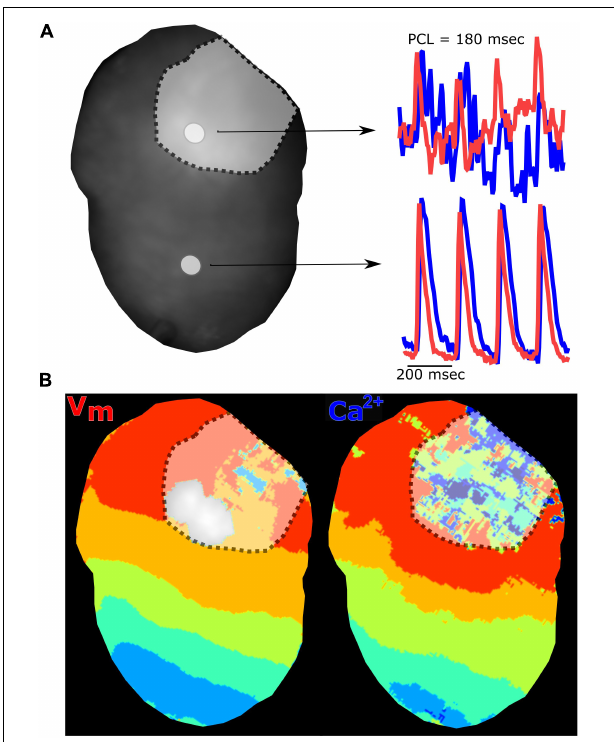
FIGURE 9 | Myocardial injury via radiofrequency ablation diminishes electrical and calcium signals. (A) Langendorff-perfused rat heart after radiofrequency ablation showing two regions of interest and corresponding traces. The voltage signal (red) and calcium signal (blue) are collected from the ablation site (denoted with dotted line) and non-ablated tissue. (B) Voltage and calcium isochronal maps display activation time across the heart, with disruption at the site of ablation injury. Epicardial dynamic pacing from the apex of the